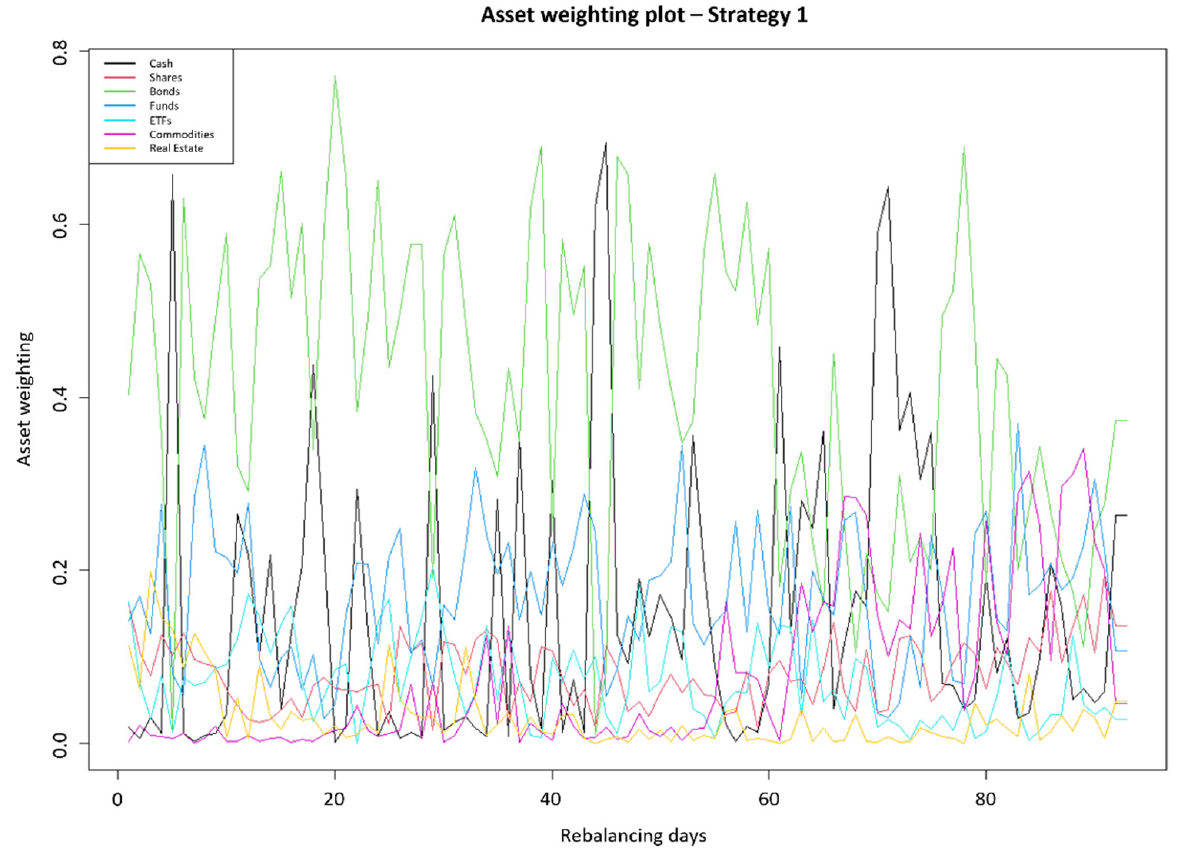
Figure 4. The asset weights plot of Strategy 1.